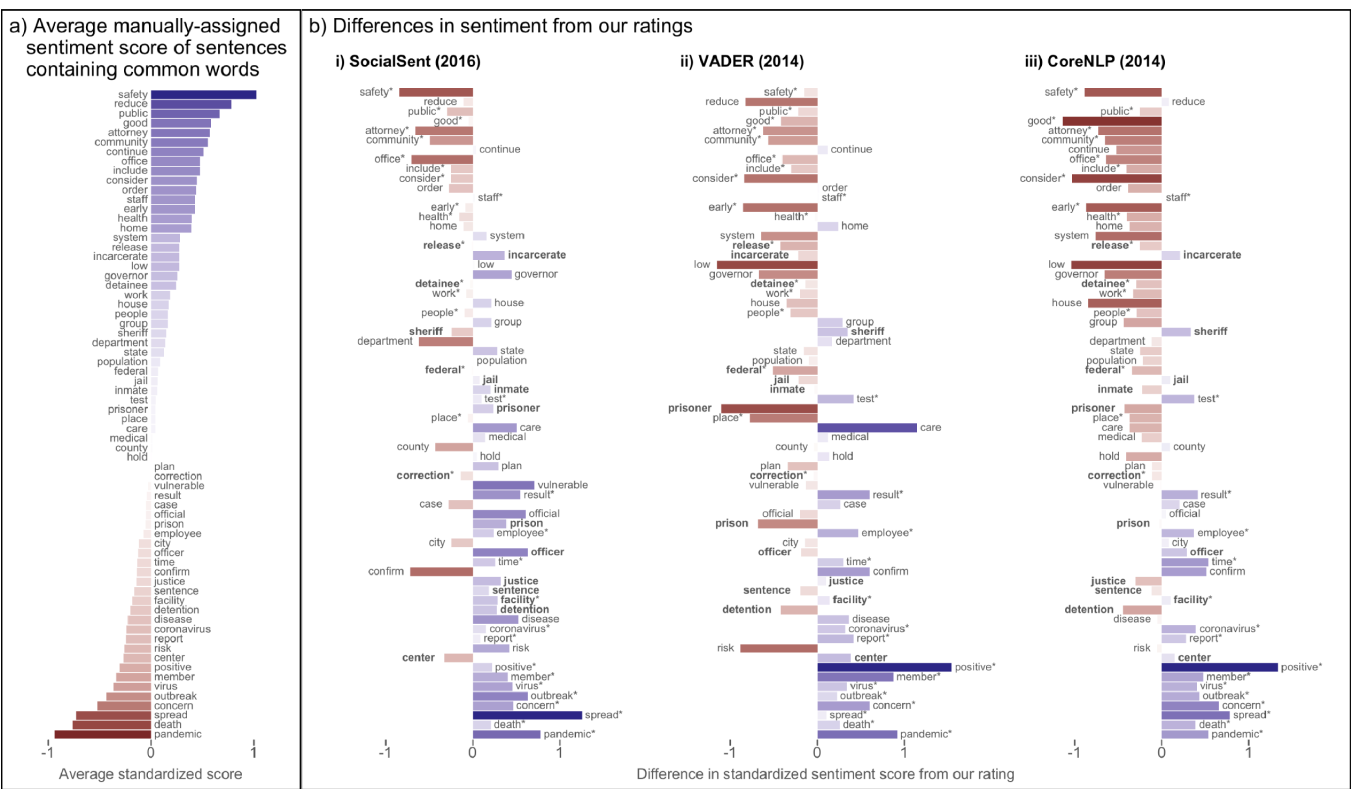
Fig 2. Average standardized sentiment scores for sentences containing each of the 68 most frequently appearing words. The words are arranged from top to bottom in order of most positive (blue) average sentiment to most negative (red), according to our human-curated scores (Panel A). Colors in Panel B indicate the relative score from each of three SA packages compared to our ratings, with red (blue) indicating that the algorithm-rated sentences with a given word more negatively (positively) than our team did. The color gradient indicates the intensity of the average standardized sentiment score for that term across sentences (i.e., light colors refer to terms rated more neutral, while darker colors refer to terms rated more negatively or more positively). The length of each bar depicts the average difference between a given package’s scores and ours. Words with direction of sentiment that differ from ours in each package are marked with an asterisk, and words relating to the criminal justice system are in bold.